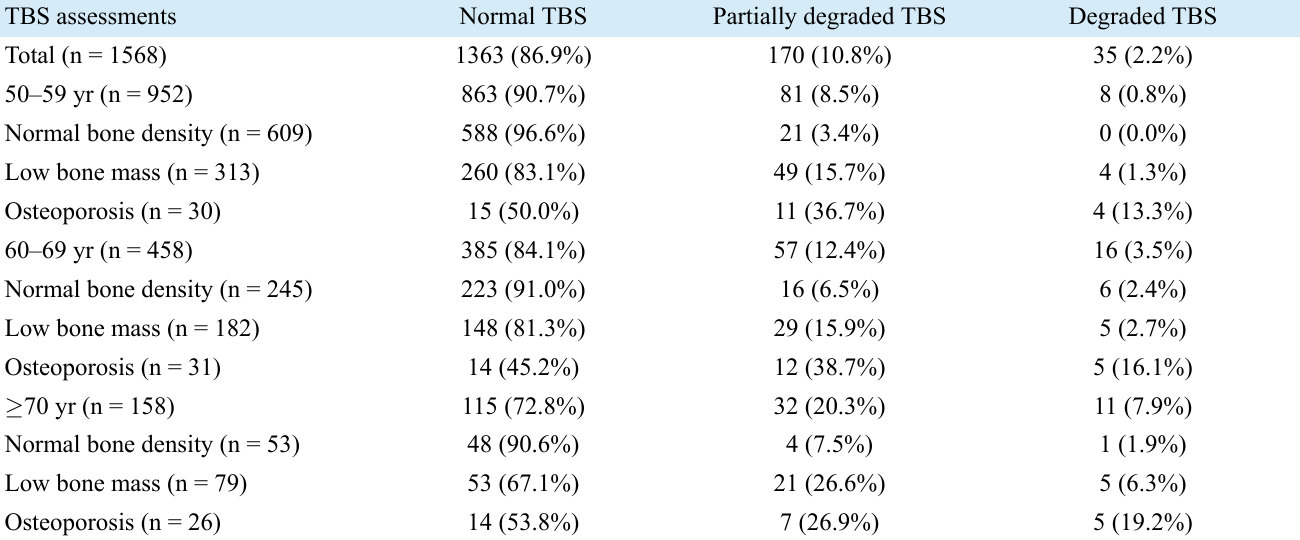
TABLE 3. Relationships between TBS and BMD across different age